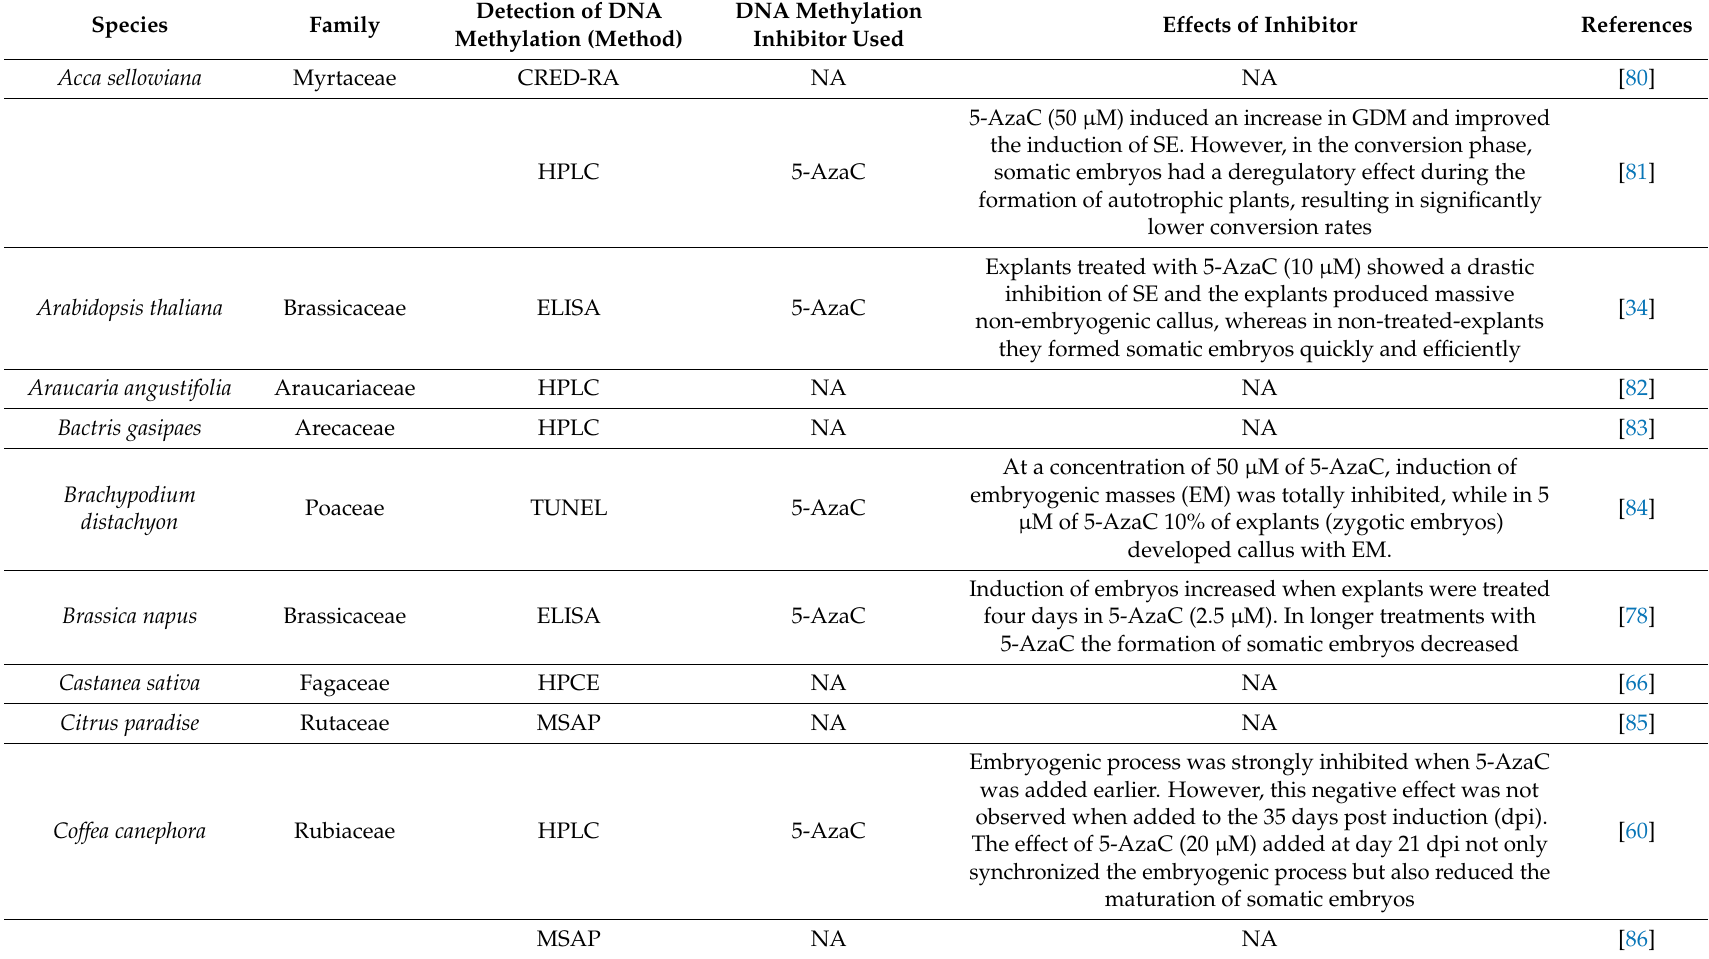
Table 1. Techniques used to evaluate DNA methylation and the effect of methylation inhibitors on the somatic embryogenesis (SE) of different species of